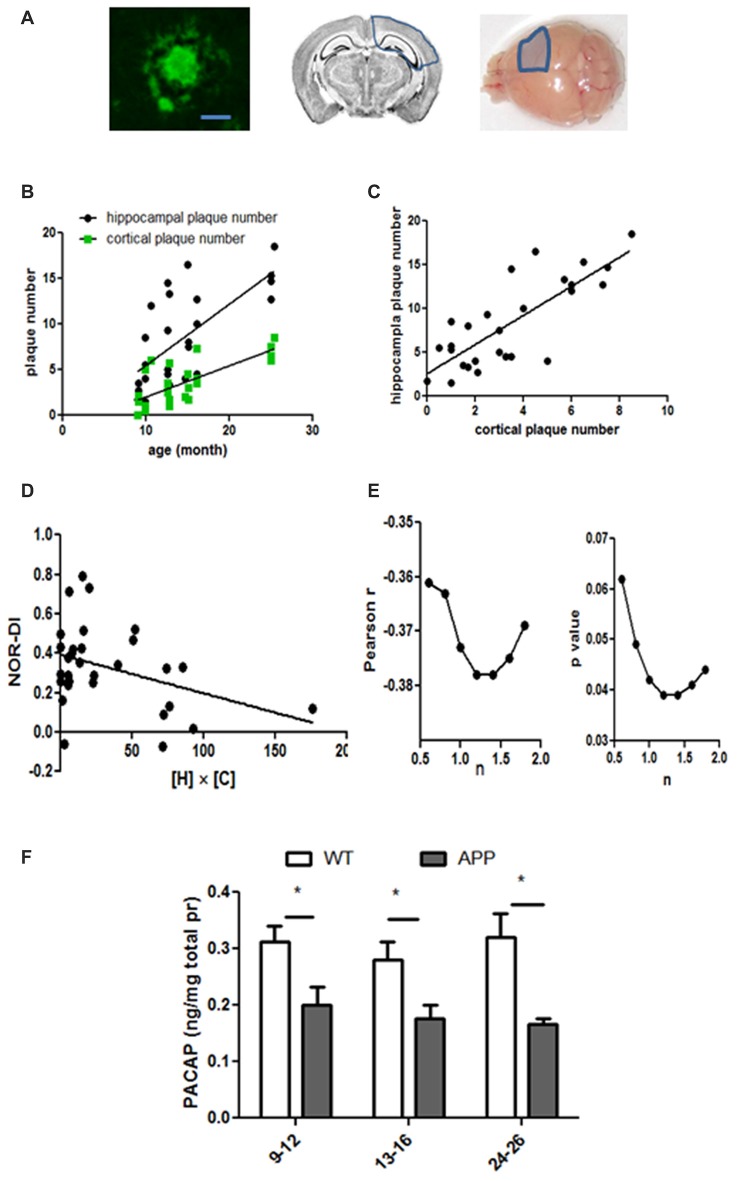
Amyloid plaque numbers in hAPP mice and their relation to age, MWM and NOR performance. (A) The left panel shows a typical plaque in hAPP mice (bar length = 20 μm). These plaques were restricted to the hippocampus and adjacent cortices. These areas were outlined by the blue lines in the middle (coronal view) and right (surface view) panels. Only one hemisphere was marked but the plaques were expressed on both sides. (B) Plaque numbers in the hippocampus and the cortex increased with age progression. Hippocampus: r2 = 0.48, p < 0.0001; cortex: r2 = 0.55, p < 0.0001. (C) The hippocampal and cortical plaque numbers correlated with each other (r2 = 0.63, p < 0.001). (D) NOR-DI inversely correlated with the product of hippocampal and cortical plaque numbers ([H] × [C]), Pearson r = −0.37, p = 0.042. (E) NOR-DI linearly correlated with n. While the linear correlation existed when n = 1 (E) the correlation remained valid (p < 0.05) when n was in the range of 0.8–1.8. The correlation was the strongest when n was between 1.2 and 1.4. (F) Cerebral PACAP levels were measured in three age groups of hAPP and WT mice. The cerebral tissues only included the hippocampus and the cortex around hippocampus (indicated as in the right panel of A). Two-way ANOVA and post hoc Bonferroni tests were applied. *Indicates p < 0.05.